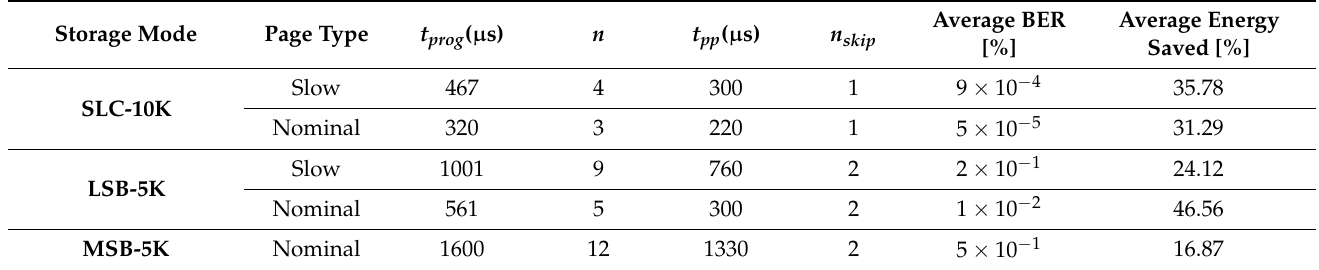
Table 3. EXPRESS characterization for NAND flash block after PE